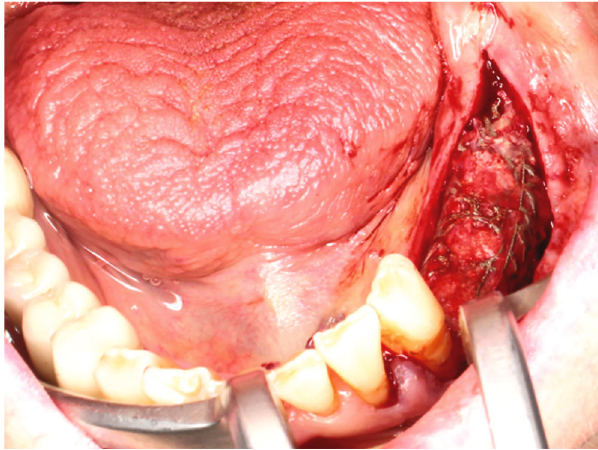
Figure 16: Exposed YxOss CBR® titanium mesh.